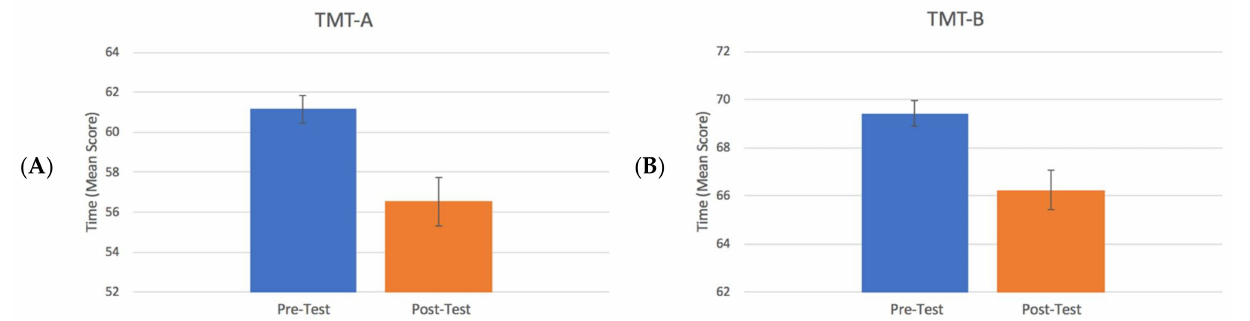
Figure 10. Results of executive function assessment tests before and after training (with 95% CI for the mean). ( A ) TMT-A assessment test results. ( B ) TMT-B assessment test